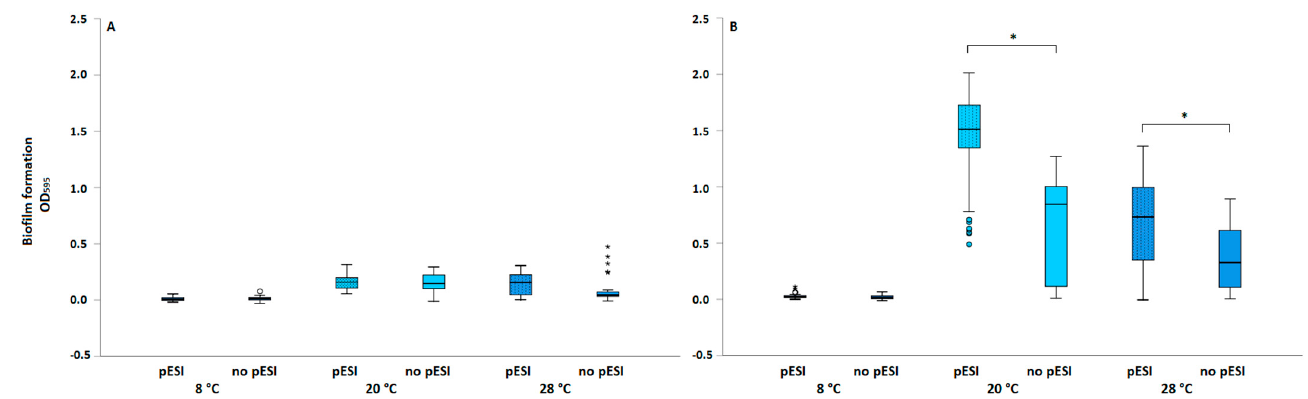
Figure 1. Biofilm formation of S. Infantis strains ( n = 15) regarding presence of pESI plasmid, under various temperature conditions and incubation times: ( A ) 72 h and ( B ) 168 h; ⋆, ○ outliers; * p < 0.05.